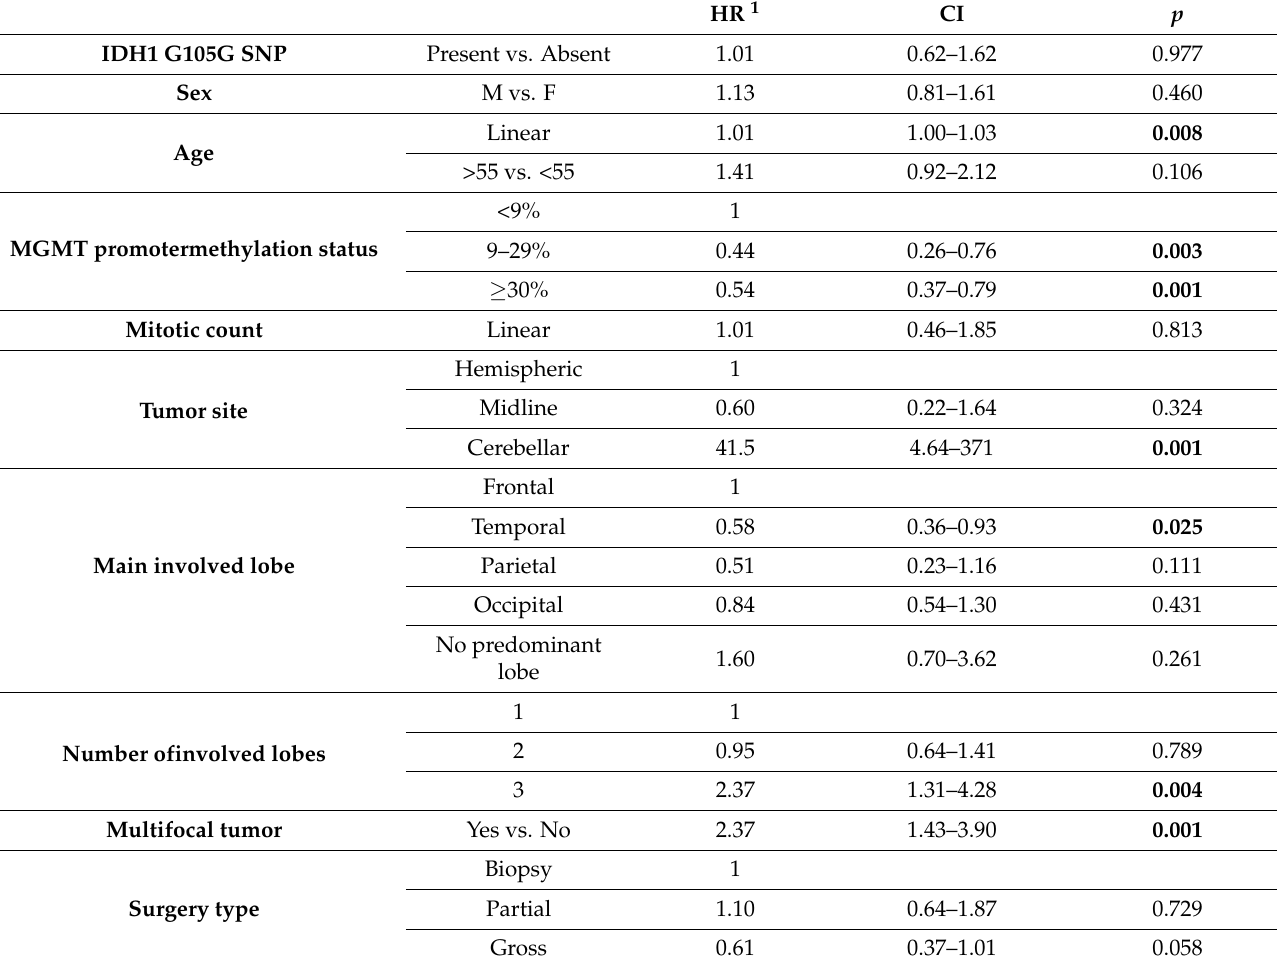
Table 3. PFS analysis of clinical/pathological/molecular features by Cox